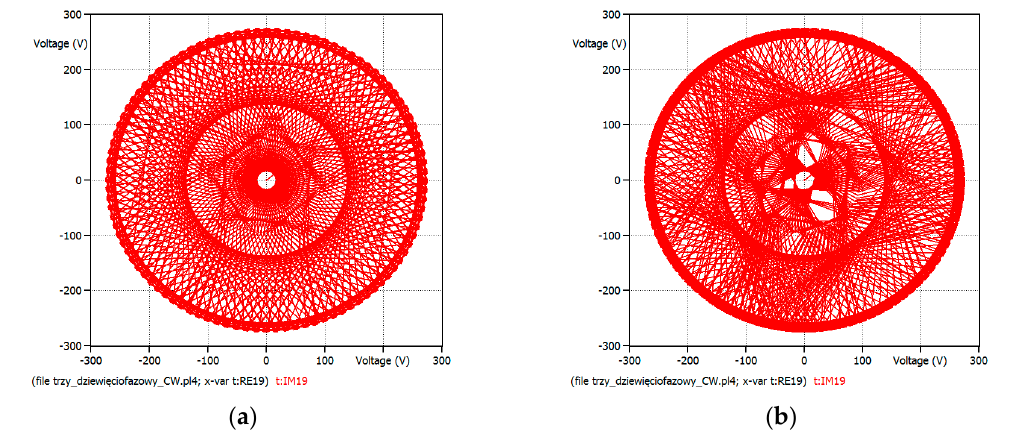
Figure 14. Trajectory of the output rotating voltage space vector for the voltage transfer ratio: ( a ) k U = 0.1; ( b ) k U = 0.5. Simulations performed for the output frequency f o = 30 Hz, for one period of output frequency and CW method.